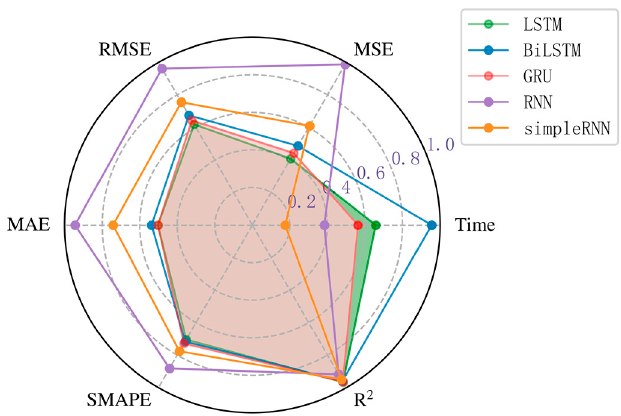
Figure 14. Schematic diagram of comparison of prediction effect of basic model.